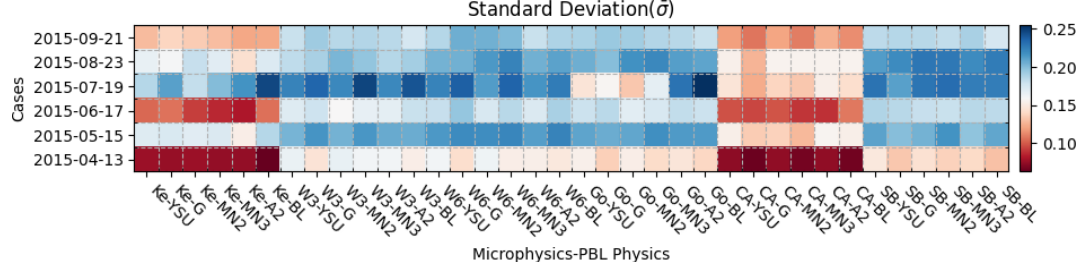
Figure 17. Heat map of the ensemble standard deviation ( ¯ σ ) of the mean total cloud fraction, averaged over the last 36h of the simulations, shown for each cluster of microphysics and PBL physics (columns) for all test cases (rows). In this heat map, blue indicates larger ¯ σ and greater ensemble